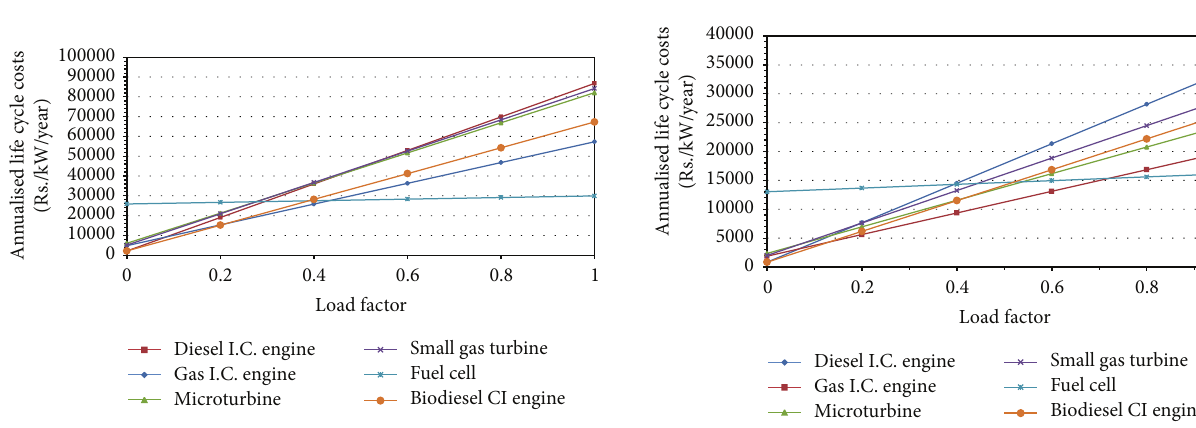
Figure 4: Comparison of annualised life cycle costs for different technological options when only DG is considered (discount rate (𝑑) = 30 %) for the month of June 2011.